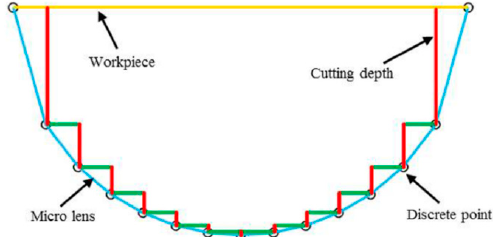
Figure 13. Schematic of the change trend of cutting depth for the equal-angle method.